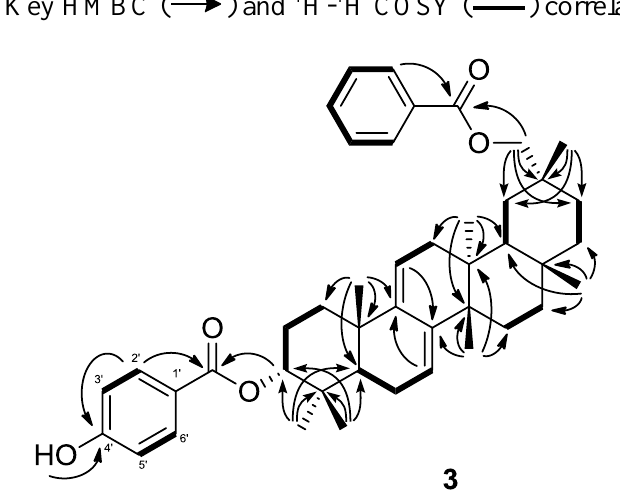
Figure 5. Key HMBC ( ) and 1 H- 1 H COSY ( ) correlations of 3 .